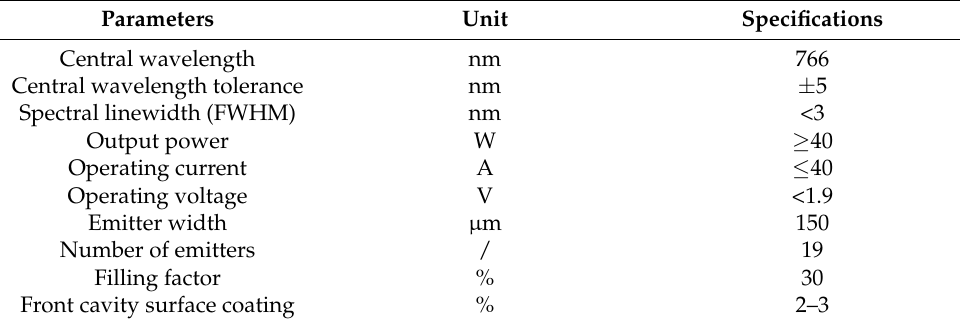
Front cavity surface